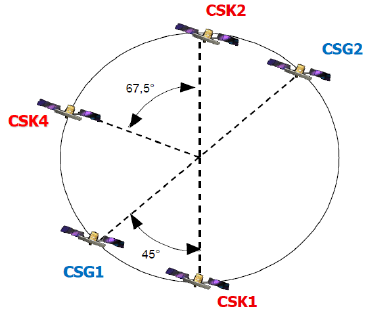
Figure 10. CSK/CSG current orbital configuration.